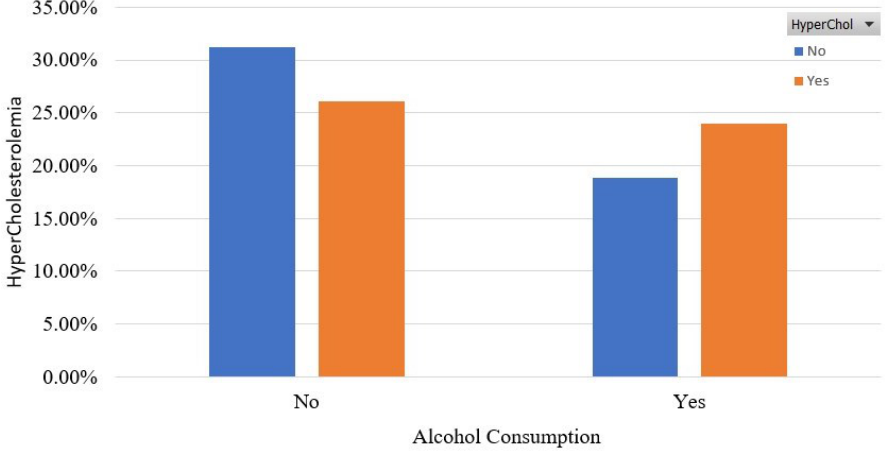
Figure 5. Participants’ distribution in terms of alcohol consumption in the balanced dataset.